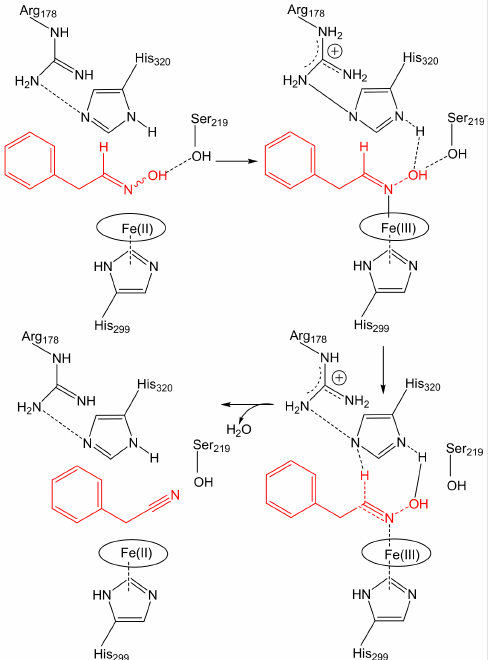
Figure 2. The binding of the substrate, phenylacetaldoxime, in the catalytic center of aldoxime dehydratase and release of the product, phenylacetonitrile; according to [18], modified. Amino acid numbering as in OxdA from Pseudomonas chlororaphis B23. Substrate and product in